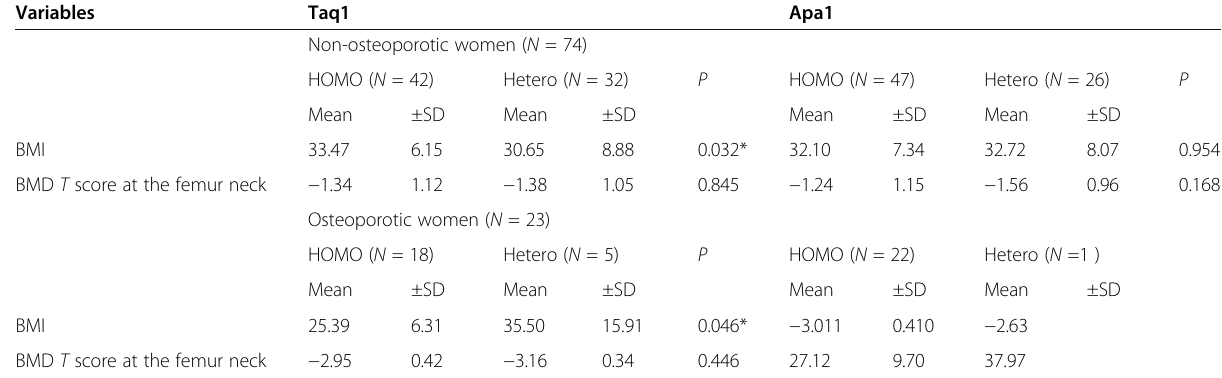
Table 4 Comparisons of means ± SD of BMI and BMD between different genotypes of TaqI and ApaI VDR in non-osteoporotic and osteoporotic women